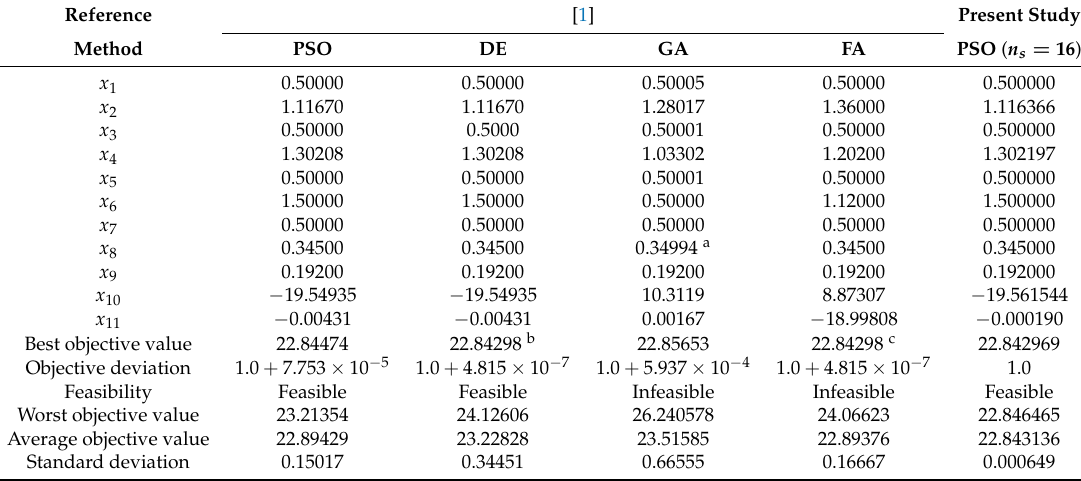
Table 12. Optimization results of the car side impact design